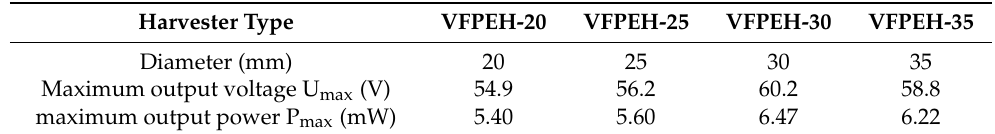
Table 3. Output characteristics of the VFPEH with different